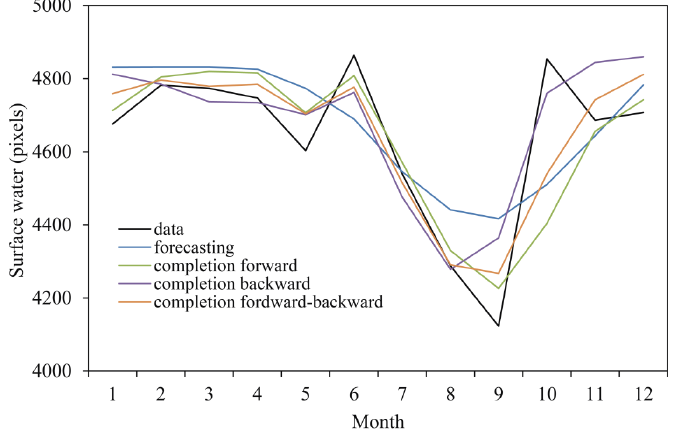
Figure 12. Mean year of the monthly dynamic of the surface water obtained by using the different estimation modes for the ensemble of regression models. The final spatiotemporal estimation of the monthly surface water (the main objective of this study) was obtained by using the best solution, the forward–backward completion approach (see Figure 13). It shows the complete monthly time series of the estimated surface water and the spatial distribution for some months (March, June, September, and December) of a dry year (1995), a wet year (2013), and an average year (2002) of the studied period (1984–2015). For these years, the aquifer discharge and the mean surface water are 38.4 Mm 3 and 3536 pixels, 49.4 Mm 3 and 5518 pixels, and 43.1 Mm 3 and 4635 pixels, respectively.